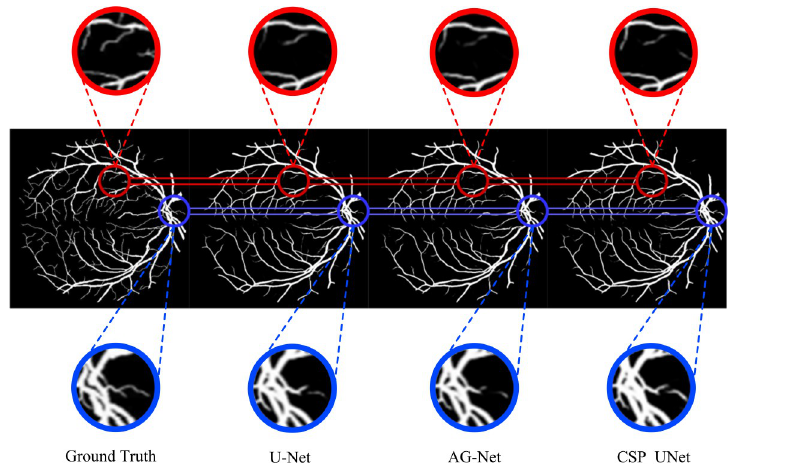
Fig 8. Comparison of segmentation details of CSP_UNet with U-Net and